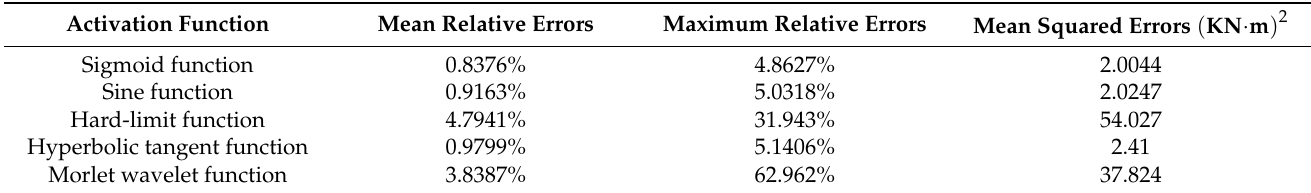
Table 3. Flight load prediction accuracy via genetic-algorithm-enhanced